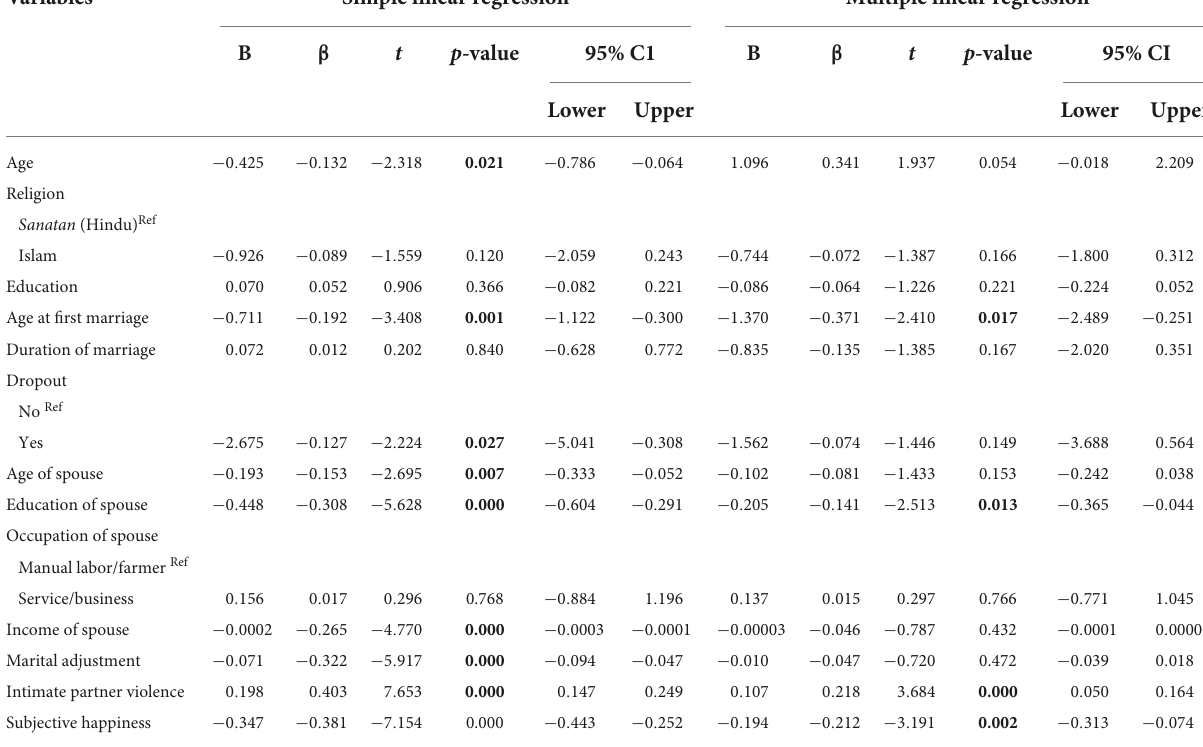
TABLE 4 Predicting stress among early married girls during the pandemic. Variables Simple linear